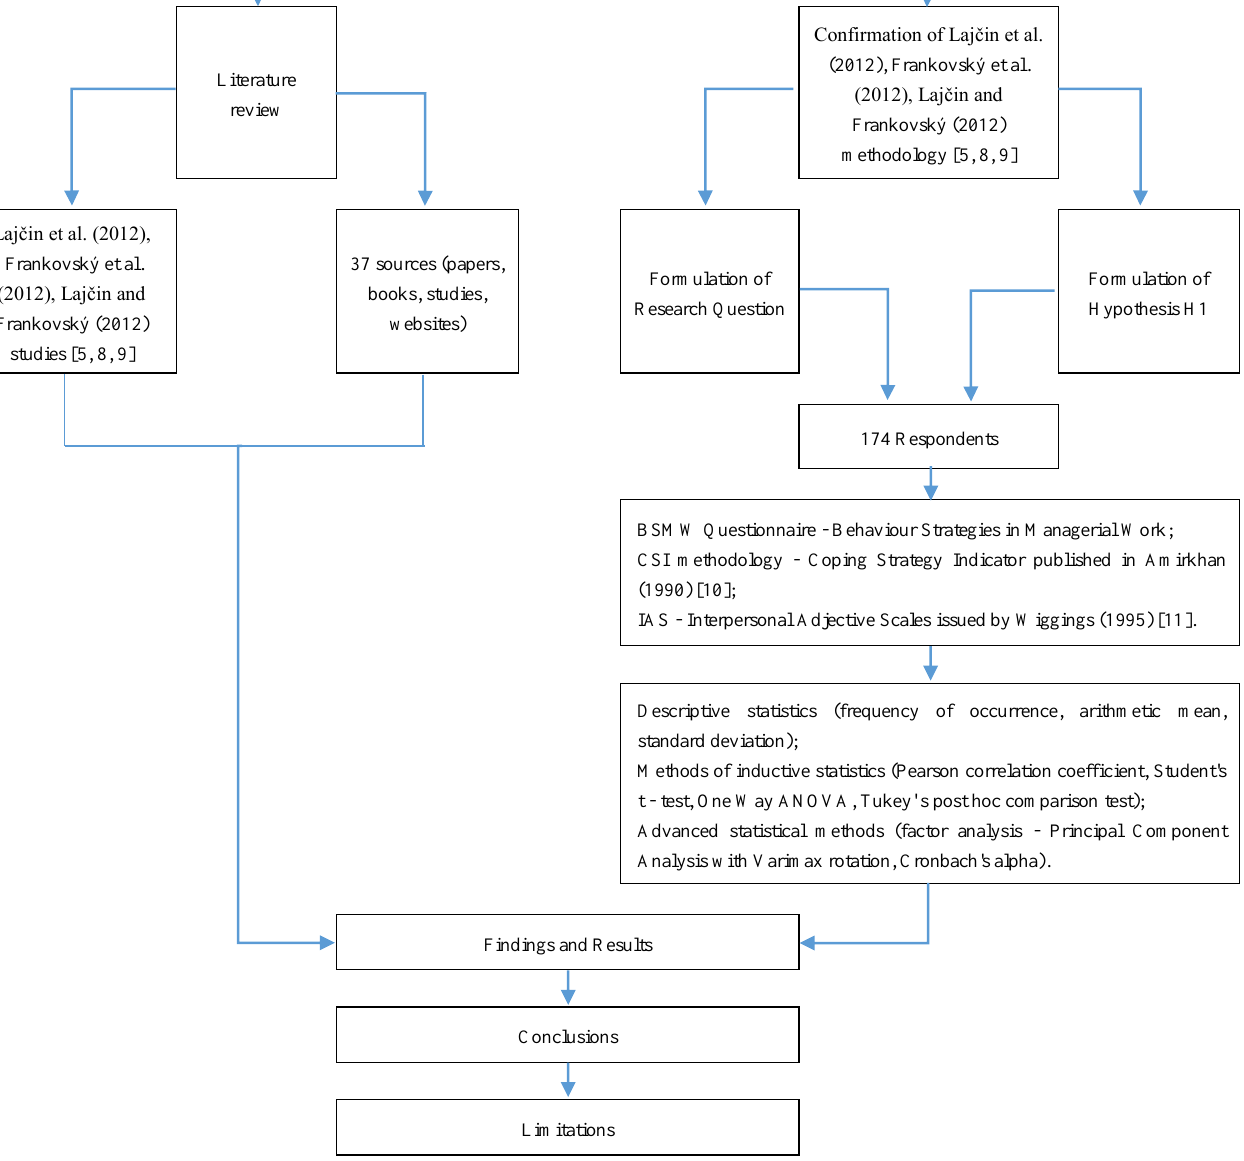
Figure 1. Methodology